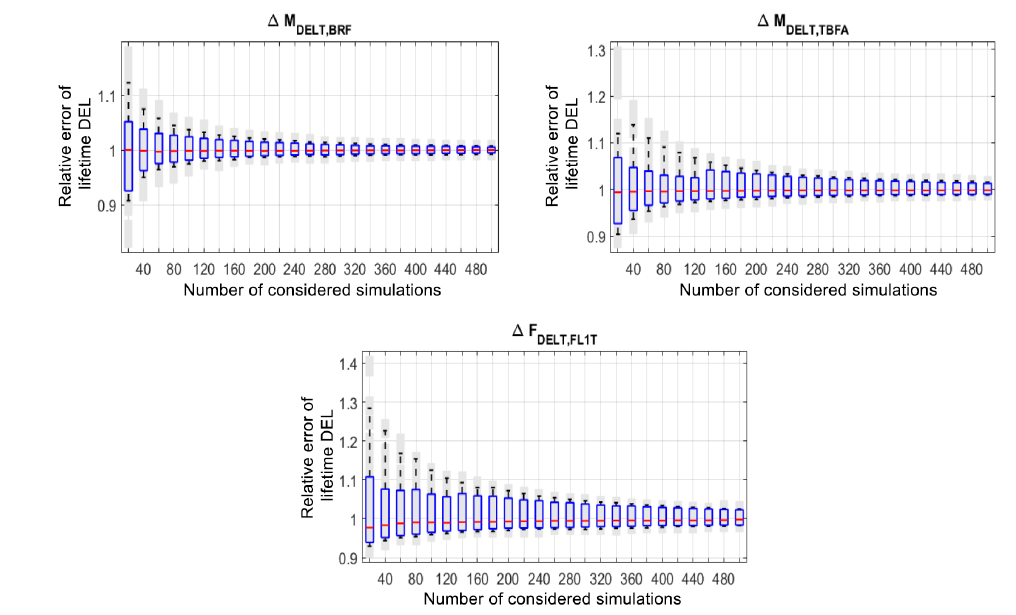
Figure 8. Bootstrap analysis of resulting lifetime DEL with an increasing number of considered samples and simulations. Results are normalized with the resulting value based on 5400 samples. Box plots indicate first and 99th percentile values (whiskers), 10th and 90th percentiles (box frames), and median values (red lines). Grey boxes indicate results from individual evaluations (baseline data for statistical evaluation).